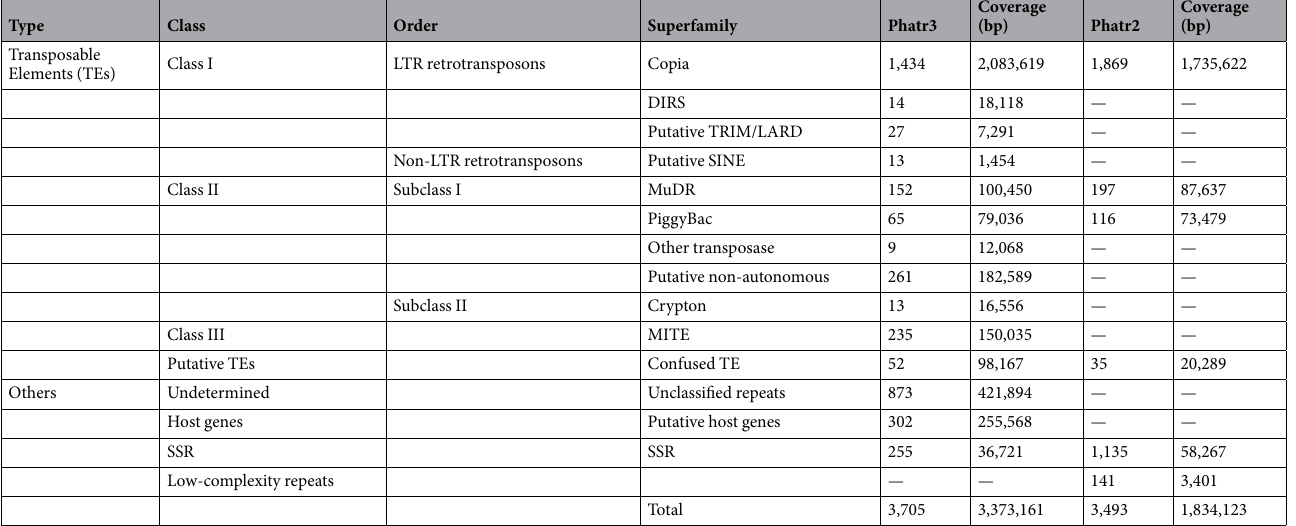
Table 2. Composition of repetitive sequence